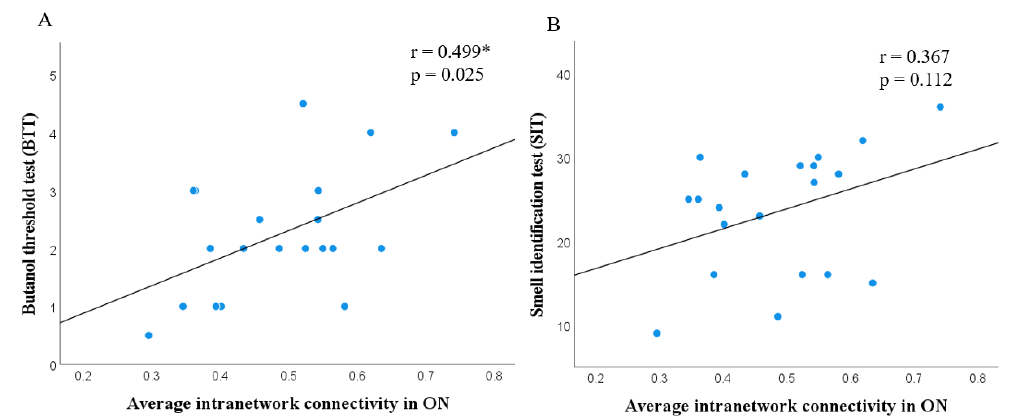
Figure 5. Scatter plot showing correlation between the average intranetwork connectivity in olfactory network and butanol threshold test (BTT) ( r = 0.499 *, p = 0.025); smell identification test (SIT) ( r = 0.367, p = 0.112) in COVID-19 patients.